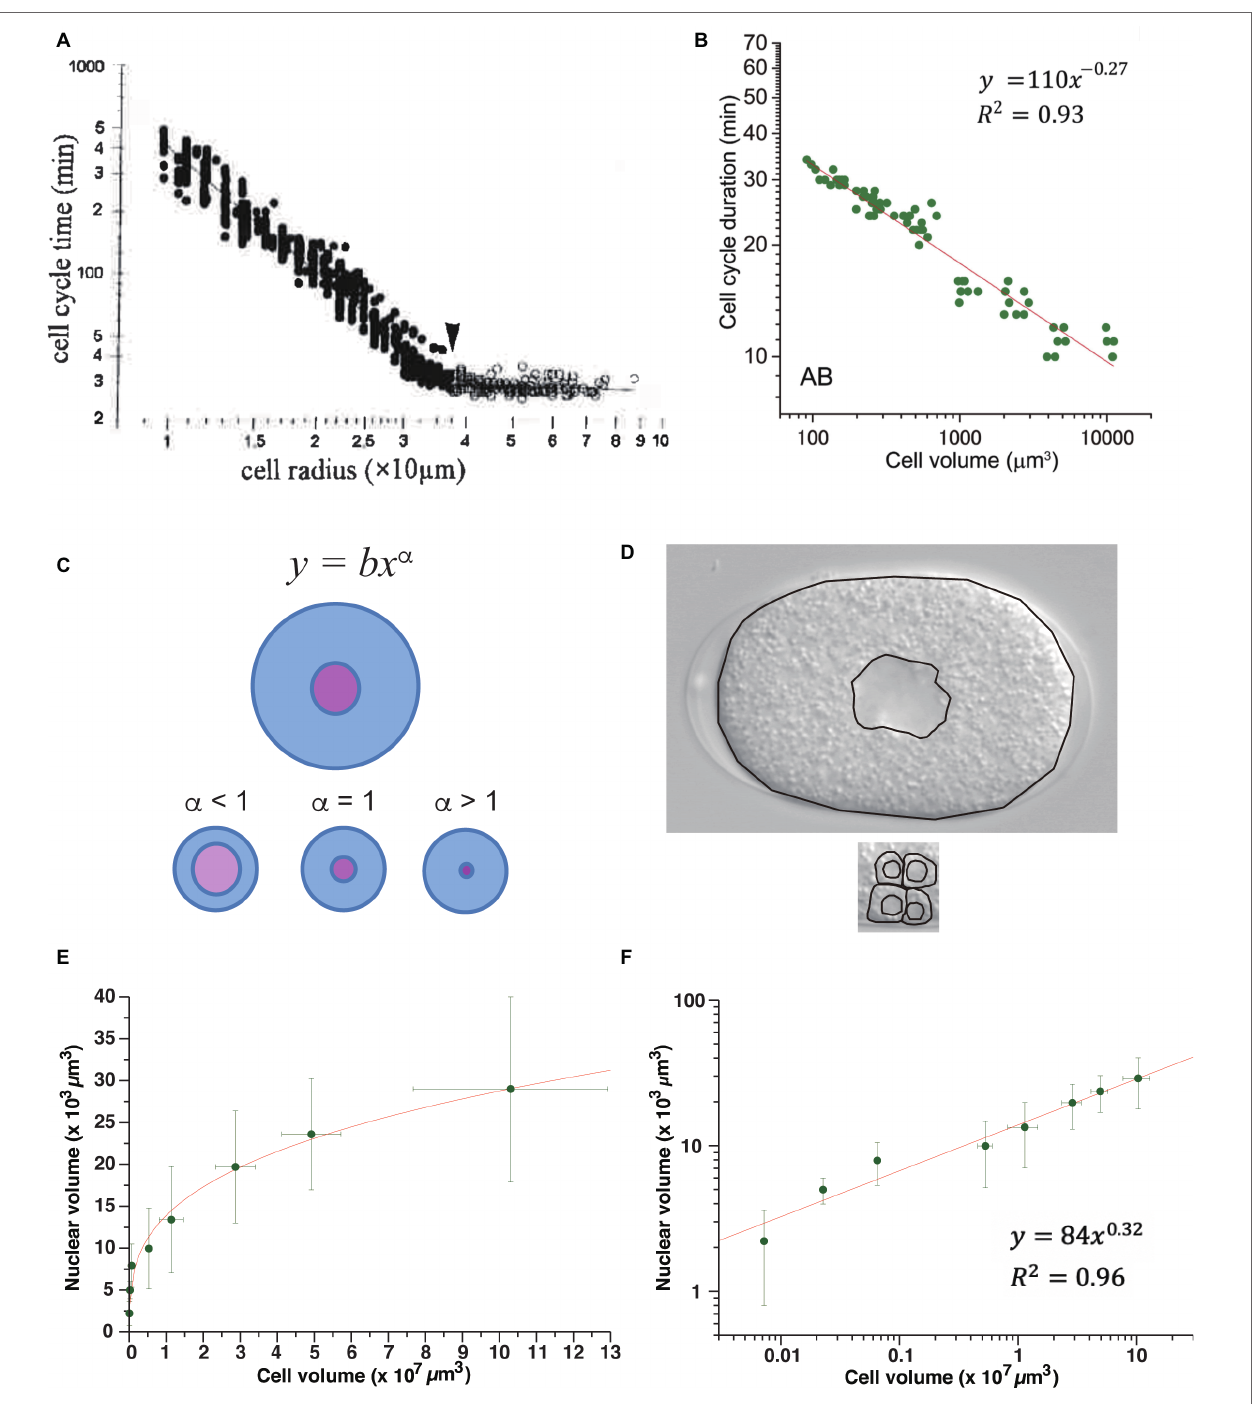
FIGURE 4 | Power-law relationship between cell-cycle duration and cell size in animal embryos. Power-law distribution between cell-cycle duration and cell size in Xenopus embryos (A) and C. elegans (B) embryos. (C) Allometric scaling between nucleus and cell volumes in C. elegans embryos. One-cell embryo (upper) and cells at later embryonic stage (lower). Scaling exponent of 0.63 in C. elegans volume relation between nucleus and cell (Arata et al., 2014) was consistent with schematic illustration of alpha <1 (see panel D ). (D) Images obtained from one-cell embryo (upper) and part of a ~100-cell embryo (lower) by differential interference contrast microscope. Boundaries of cell and nucleus are traced by black lines. Compare ratio of nuclear and cell areas between one-cell embryo and part of ~100- cell embryo. (E,F) Allometric scaling between nuclear and cell volumes after cell cleavages during Xenopus early development. Average values and standard deviation at each stage were extracted from graph plot in Figure 1B in (Jevti ć and Levy, 2015). Data are shown in a linear plot (E) and log-log plot (F) . Fitting was performed by linear least-squares method in log-log graph. Copyright permission of Panel (A) (Wang et al., 2000) was obtained from John Wiley & Sons, Inc. Panel (B) is reused due to Creative Commons license CC-BY (Arata et al.,